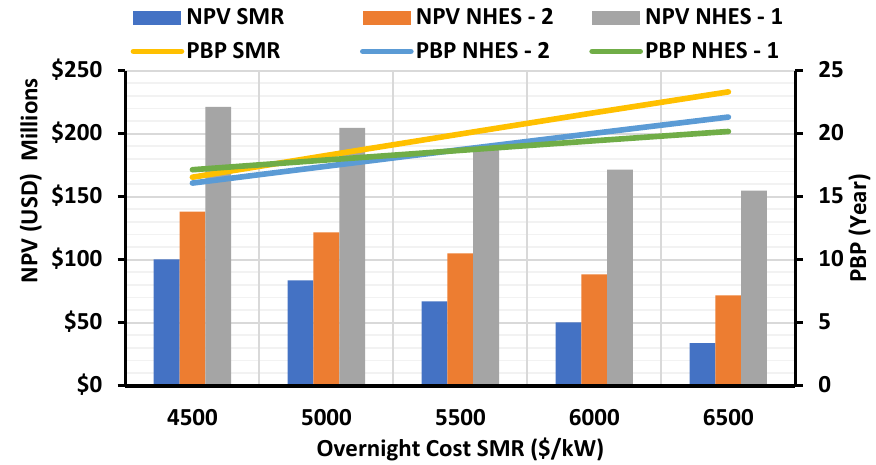
Figure 15. NPV and PBP vs. overnight cost of advanced SMR for Northwest region.